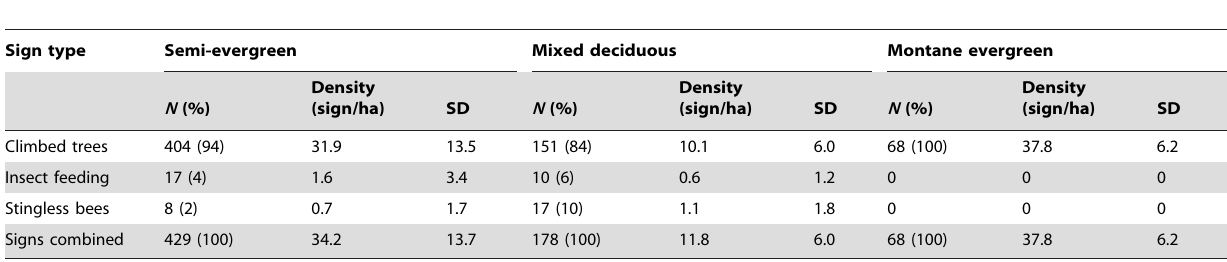
Table 1. Signs of sun bears and black bears (species combined; all sign ages) recorded in sign transects ( n =71) in three forest types of Thung Yai Naresuan Wildlife Sanctuary, Thailand, 2001–2003.